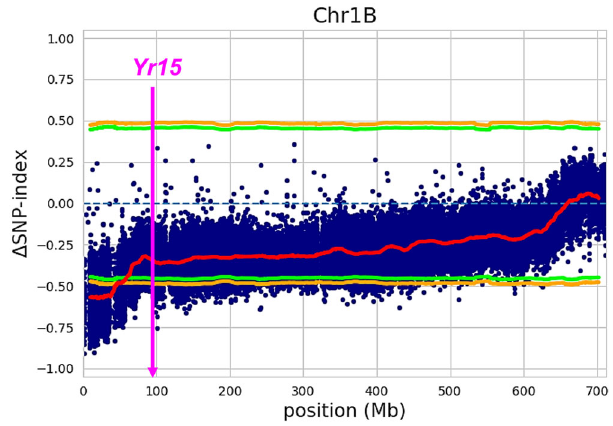
Fig. 2 Graphical representation of the results of BSA-Seq analysis for chromosome 1B with enrichment in the 0-52.7Mb region. Each blue dot corresponds to a SNP between the DNA bulks. The red line indicates the mean Δ SNP-index. Orange and green lines represent coverage-adjusted con fi dence interval of the simulated Δ SNP-index at 99% and 95%, respectively. The physical position of the cloned stripe rust resistance gene Yr15 is